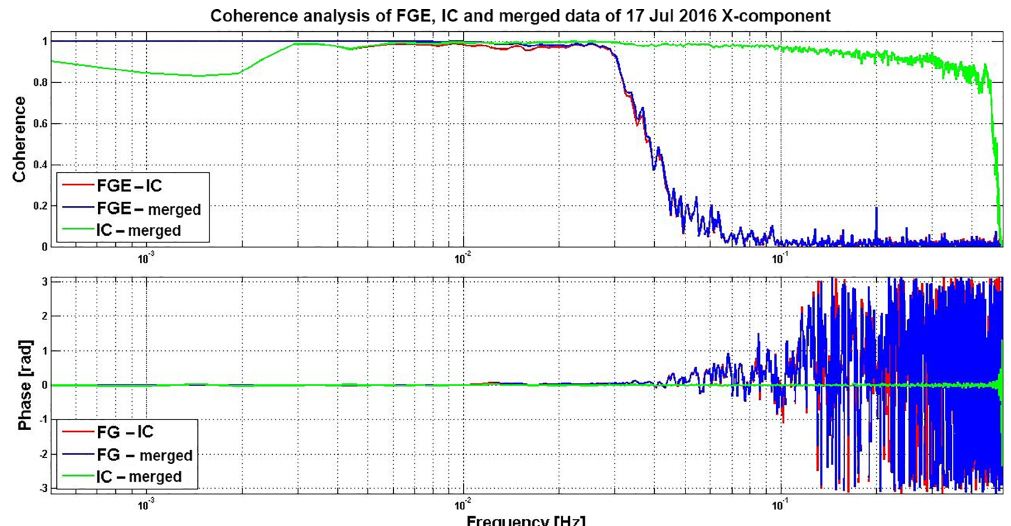
Figure 4. Coherences between FGE, merged data and induction coil (IC) data. A perfect coherence between merged data and FGE data (blue) is observed at low frequencies ( < 0.01Hz). At high frequencies ( > 0.03Hz) the coherence is high between merged data and IC data